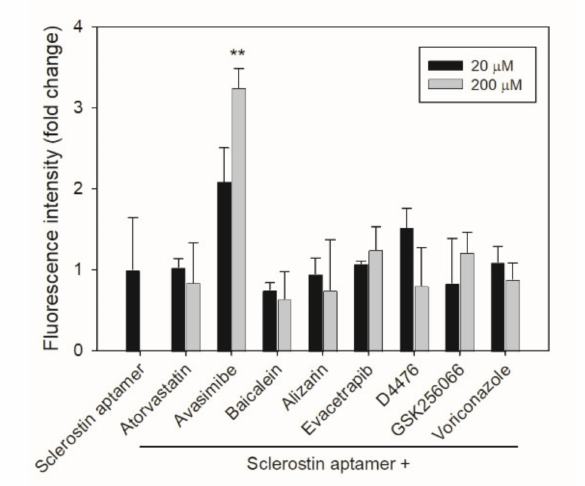
Figure 4. Fluorescence quenching effect of the potential sclerostin inhibitors. Each chemical com- pound was mixed with 500 nM FAM-labeld sclerostin aptamer at 20 or 200 µ M in a nickel-coated 96-well black plate in the absence of immobilized sclerostin for 1 h. Fluorescence intensity was determined by a TECAN Infinite 200 PRO F Nano + microplate reader at Ex485 nm/Em520 nm. Error bars represent standard deviations ( n ≥ 3). ** p < 0.01, compared to the control. 2.3. Intracellular and Extracellular Levels of Sclerostin in Mouse IDG-SW3